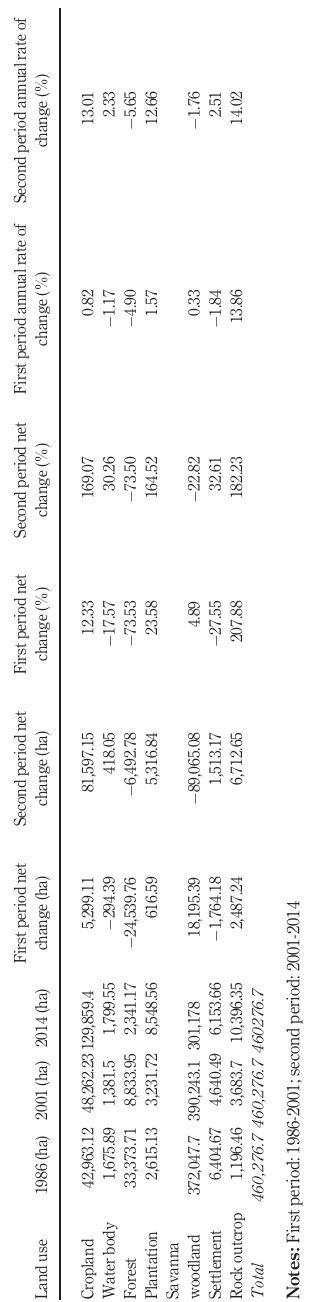
Table I. LULC changes for two time intervals: 1986-2001 and